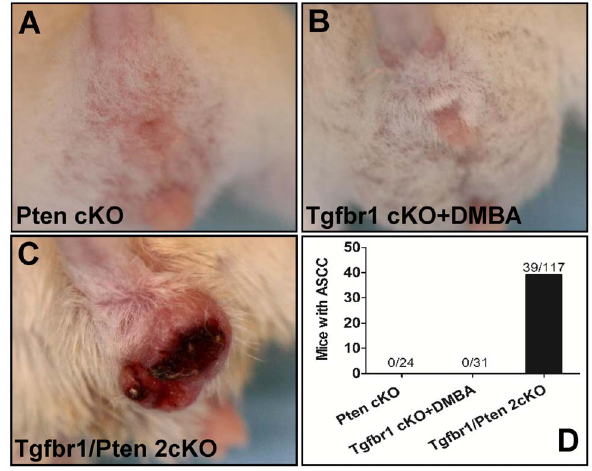
Figure 1. Anal squamous cell carcinoma in Pten cKO mice, Tgfbr1 cKO mice and Tgfbr1/Pten 2cKO mice. ASCC tumors were not observed in Pten cKO mice (A), Tgfbr1 cKO mice (B). ASCC tumor was located in the anal canal and perianal skin area of Tgfbr1/Pten 2cKO mice. (D) The frequency of ASCC tumors observed in Pten cKO, Tgfbr1 cKO and Tgfbr1/Pten 2cKO